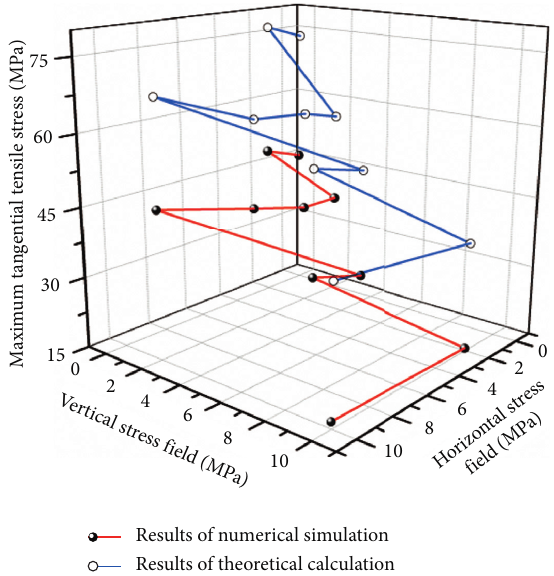
Figure 10: Comparison of the values of maximum tensile